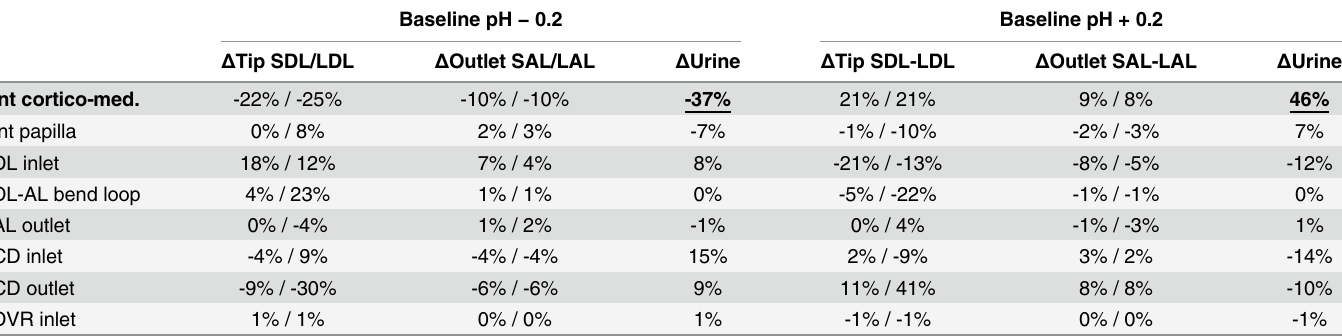
Table 2. Effects of pH changes.